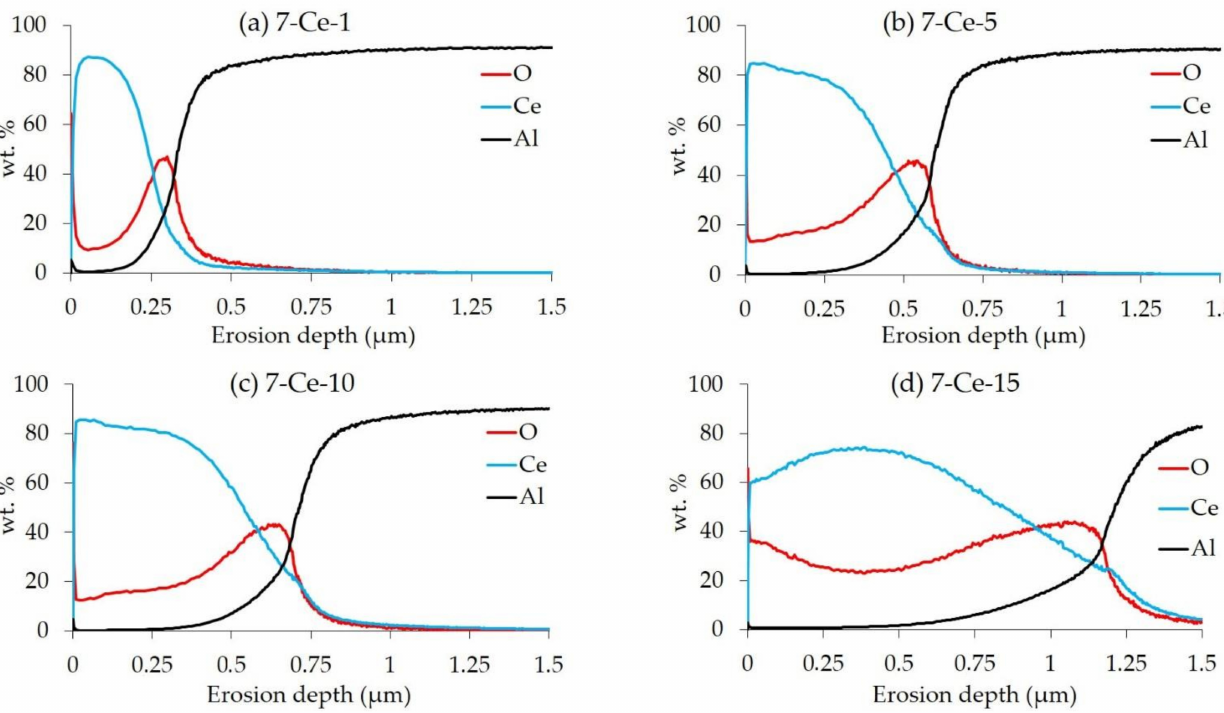
Figure 4. GDOES depth profiles of 7075 samples: ( a ) 7-Ce-1, ( b ) 7-Ce-5, ( c ) 7-Ce-10, and ( d )